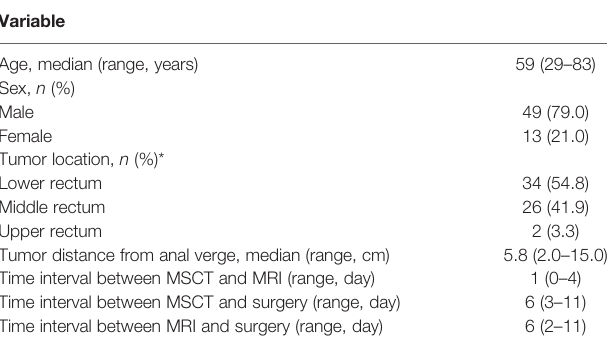
TABLE 2 | Demographics, tumor, and imaging exam time characteristics in the 62 study patients. Variable